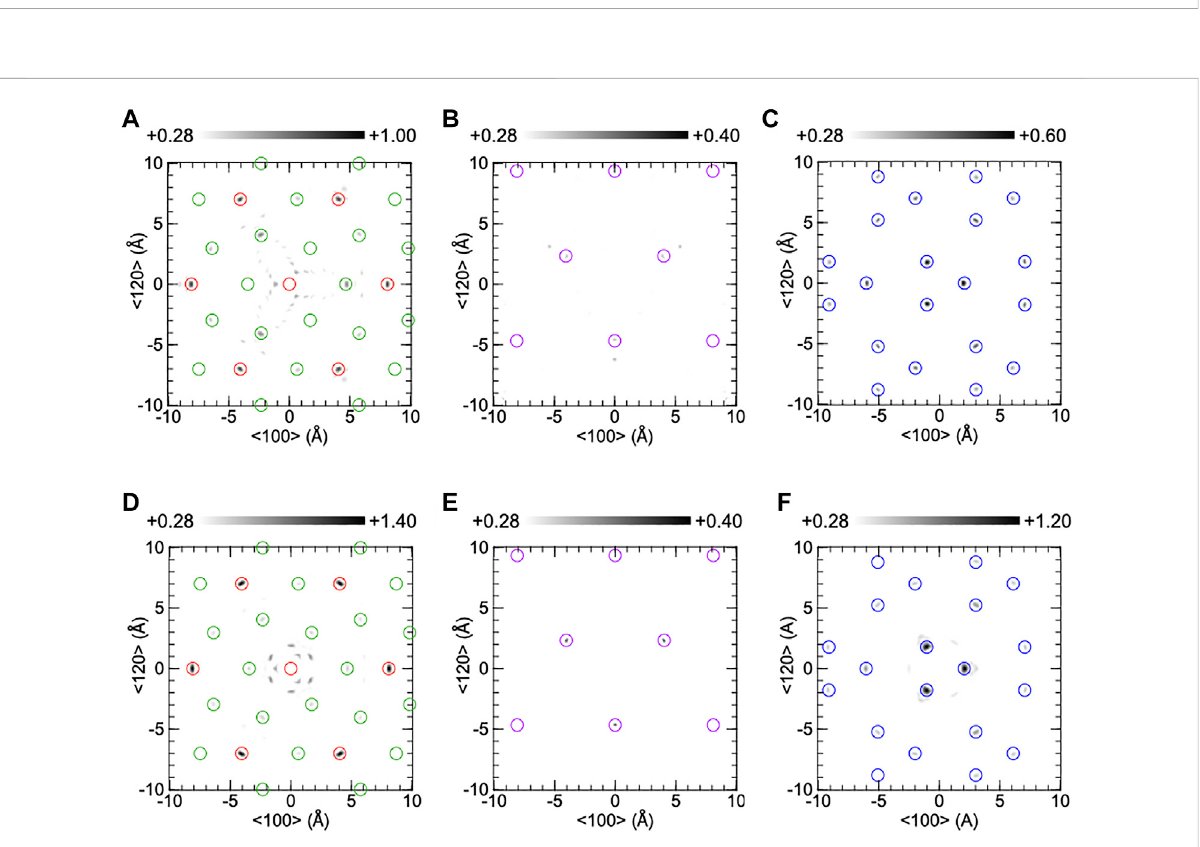
FIGURE 5 Reconstructed atomic images on the (001) plane of CTGS crystal at z = 0Å (A,D) , 2.24Å (B,E) , and 2.49Å (C,F) . The upper and lower parts were obtained from experiment and simulation, respectively. Red, green, purple, and blue circles indicate the positions of Ta, Ca, Si, and Ga